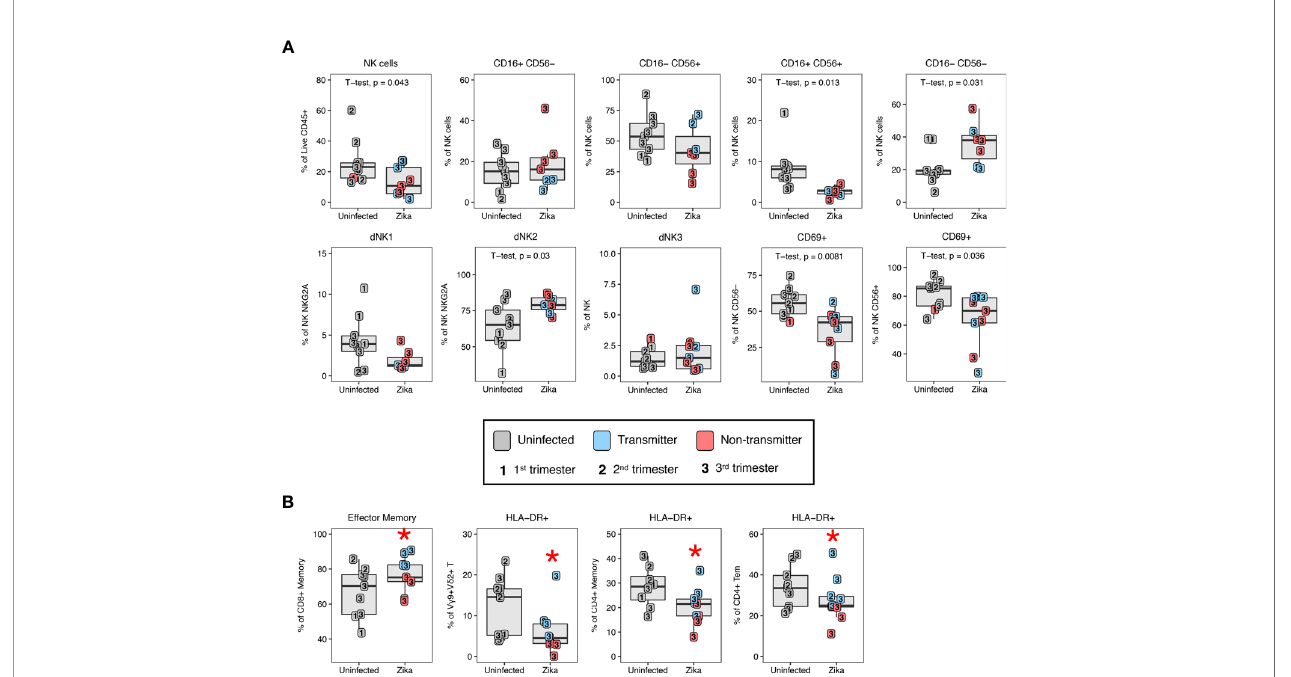
FIGURE 12 | Changes in decidual NK cells in ZIKV-infected dams and immune correlates of transmission. (A) Altered NK cell subsets by CD16/CD56, granzyme B, KIR3DL01, and CD169 in the decidual leukocytes of uninfected (n=9) (grey) and ZIKV-infected (n=9) dams. In the ZIKV-infected group, animals with detected amniotic fl uid transmission displayed in blue and non-transmitters in red. P-values < 0.05 (unpaired t-test) shown on the plots. (B) Immune parameters signi fi cantly different between transmitter and non-transmitter dams. P-value <0.05 between transmitters and non-transmitters shown as red asterisk. Normal decidual leukocytes are displayed for